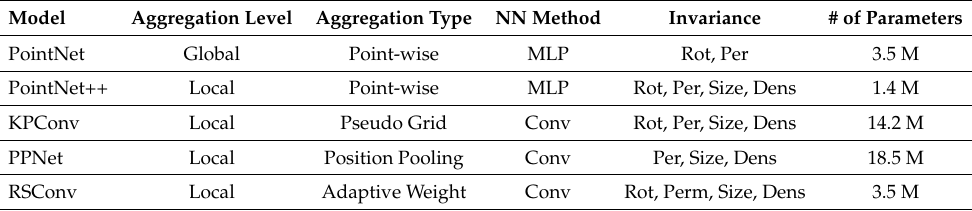
Table 2. Summary of deep learning models and their design characteristics. Please note that we use certain abbreviations, i.e NN: Neural Network , Conv: Convolution , MLP: Multi-Layer Perceptron , Rot: Rotation , Per: Permutation , Dens: Density , #: number